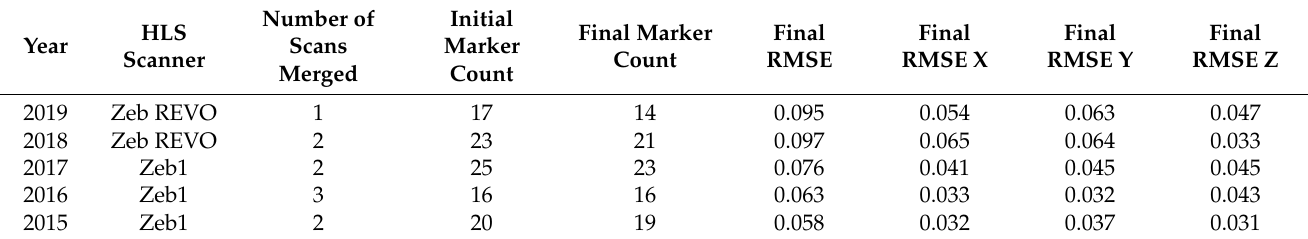
Table 2. Transform characteristics for each year and residual errors in survey marker locations (obtained using GIS method) compared to RTK after rigid transform has been applied. Initial and final survey marker counts indicate the removal of survey markers with excessively large residuals (likely due to poor or erroneous detection). RMSE are in units of meters